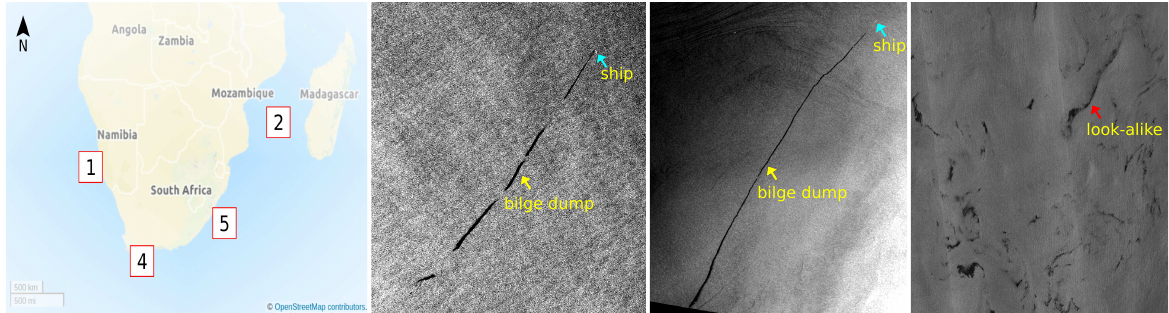
Figure 1. From Left to Right: 1) A Southern Africa region map showing the number of images and locations for the study. 2) Bilge dump between Mozambique and Juan de Nova Island coastal area (28 August 2015 Sentinel-1A IW mode). 3) Bilge dump over South Africa coastal area (14 April 2016 Sentinel-1A IW mode). 4) An example of Sentinel-1A (IW mode) with linear dark-spots that are